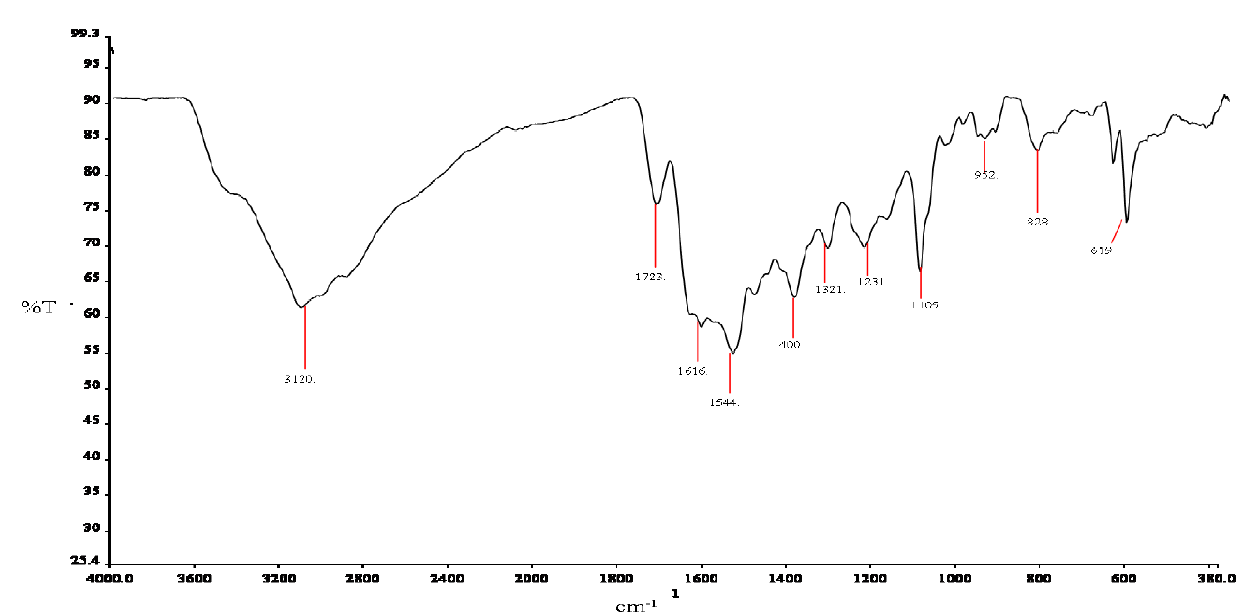
Figure 5. ATR-IR spectrum of Ru-carnosine